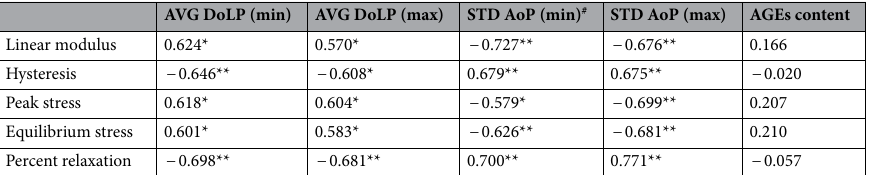
Table 3. Correlation matrix for relationship between measures of tendon tensile mechanics with collagen alignment and advanced glycation end-product (AGEs). *Indicates p < 0.05, **Indicates p < 0.01; Values are Pearson correlation coefficient unless otherwise noted, # Indicates Spearman’s rho; advanced glycation end- products (AGEs), average degree of linear polarization (AVG DoLP), standard deviation angle of polarization (STD AoP), minimum (min), maximum